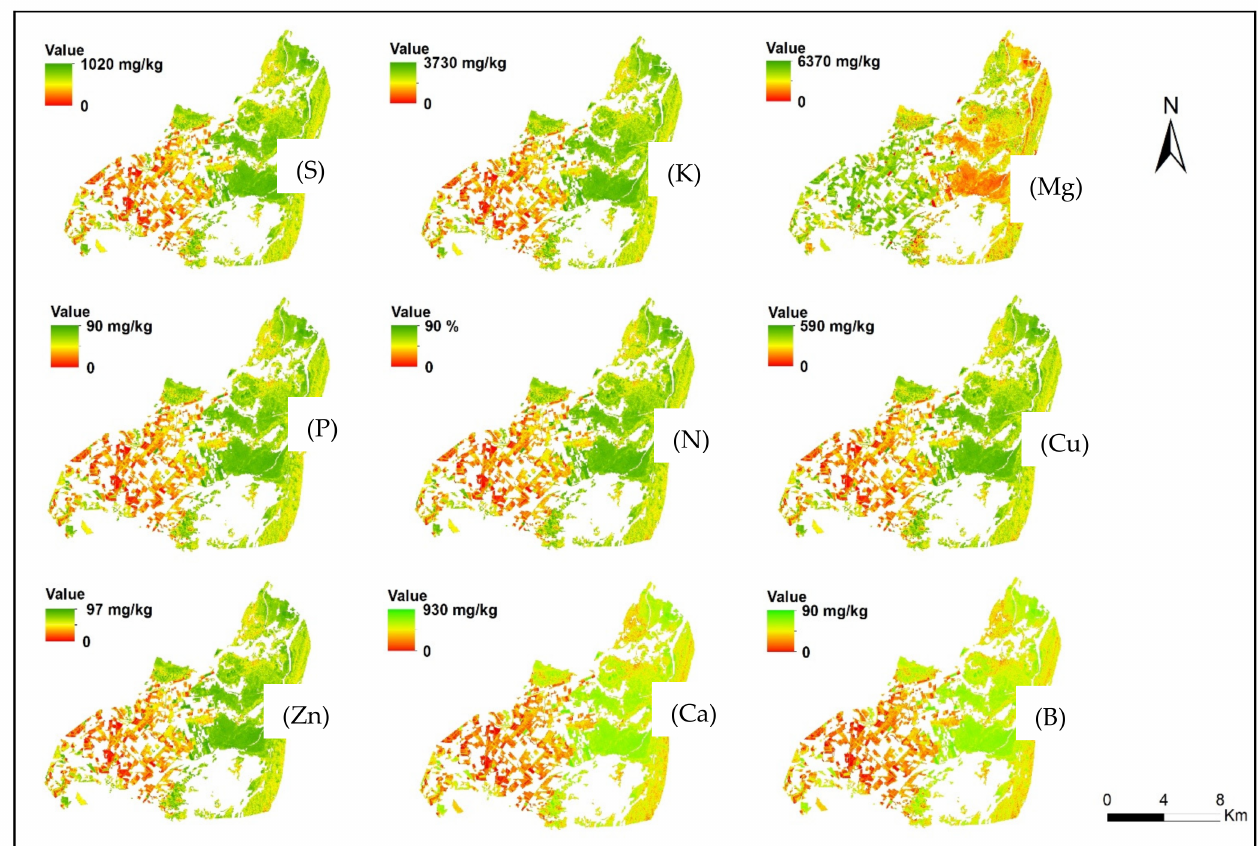
Figure 5. Spatial distribution of nutrients: S, K, Mg, Cu, N, P, Zn, Ca and